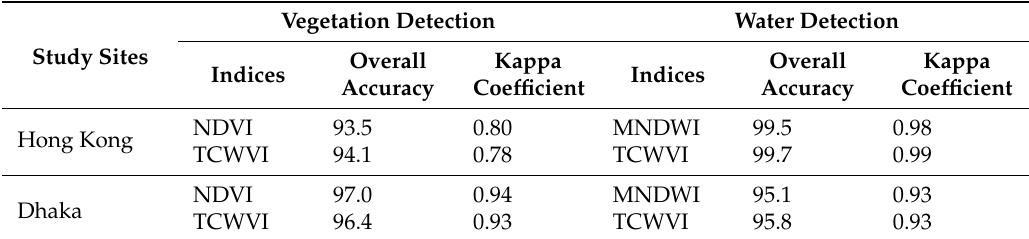
Table 5. Sensitivity of indices in the detection of vegetation and water.